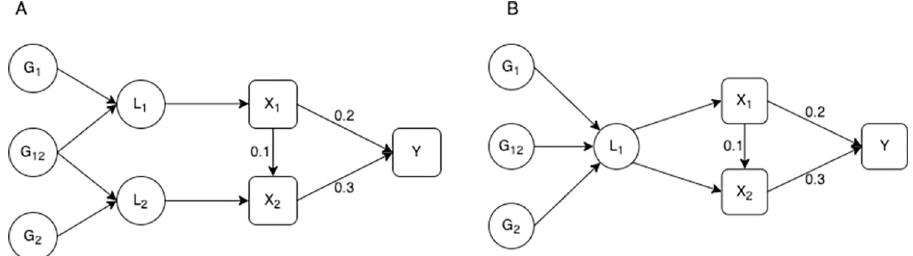
Fig 2. Models with different relationships between the genetic variants and the exposure at each time point. – L 1 is the liability in the first time period, L 2 is the liability in the second period. G 1 is a set of genetic variants associated with L 1 , G 2 is a set of genetic variants associated with L 2 and G 12 is a set of genetic variants associated with both L 1 and L 2 . X 1 and X 2 are observed values of the exposure, where X 2 is observed at a later point in an individual’s life than X 1 . Y is an outcome.